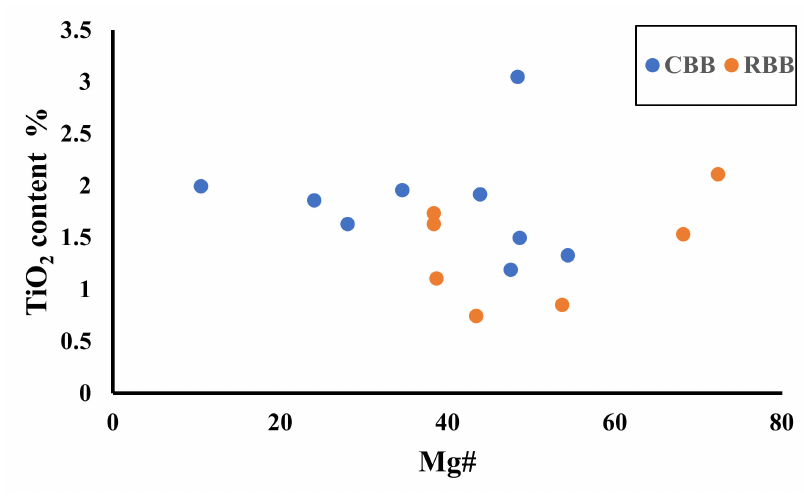
Figure 8. TiO 2 and Mg # content of the Orientale basalts.